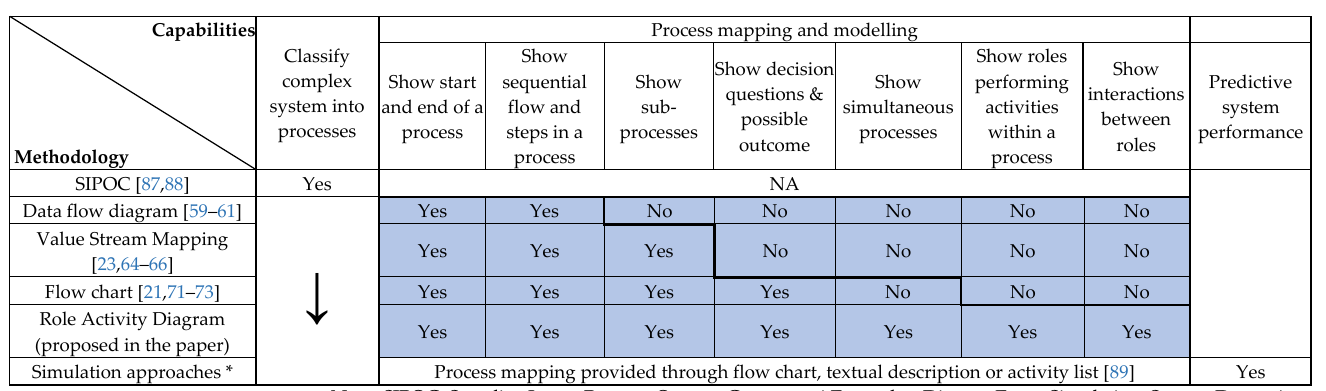
Table 1. Comparison of commonly used system modelling